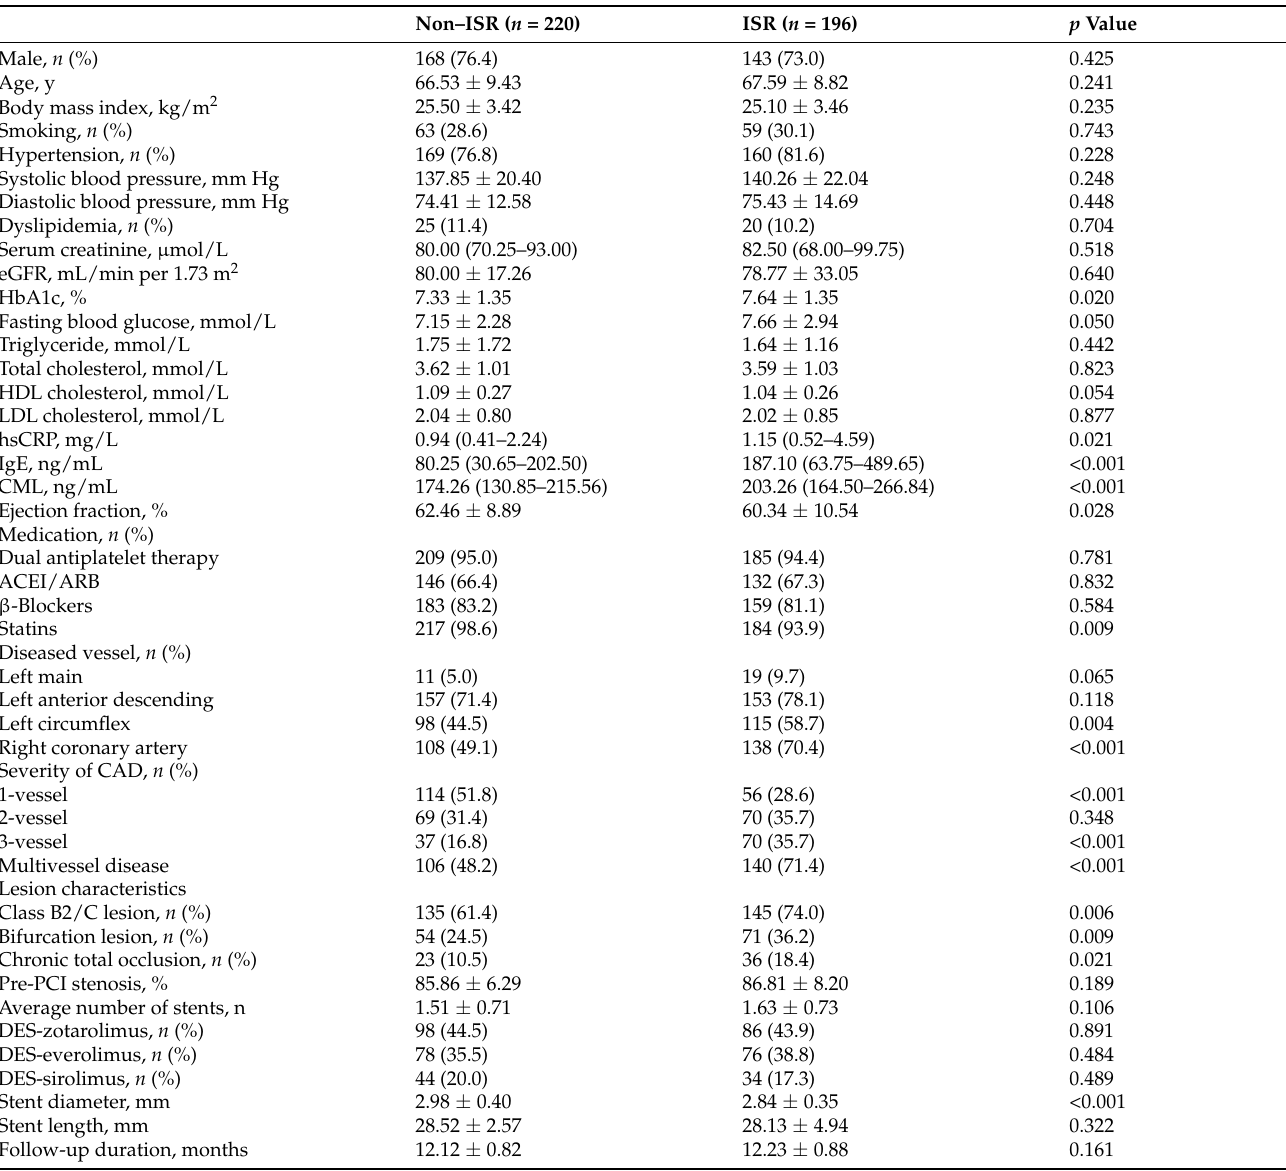
Table 1. Baseline characteristics in patients with